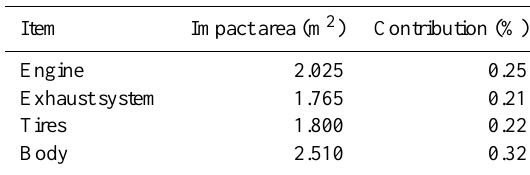
Table 2. Weighting of traffic area impact zones (Khalifa et al.,